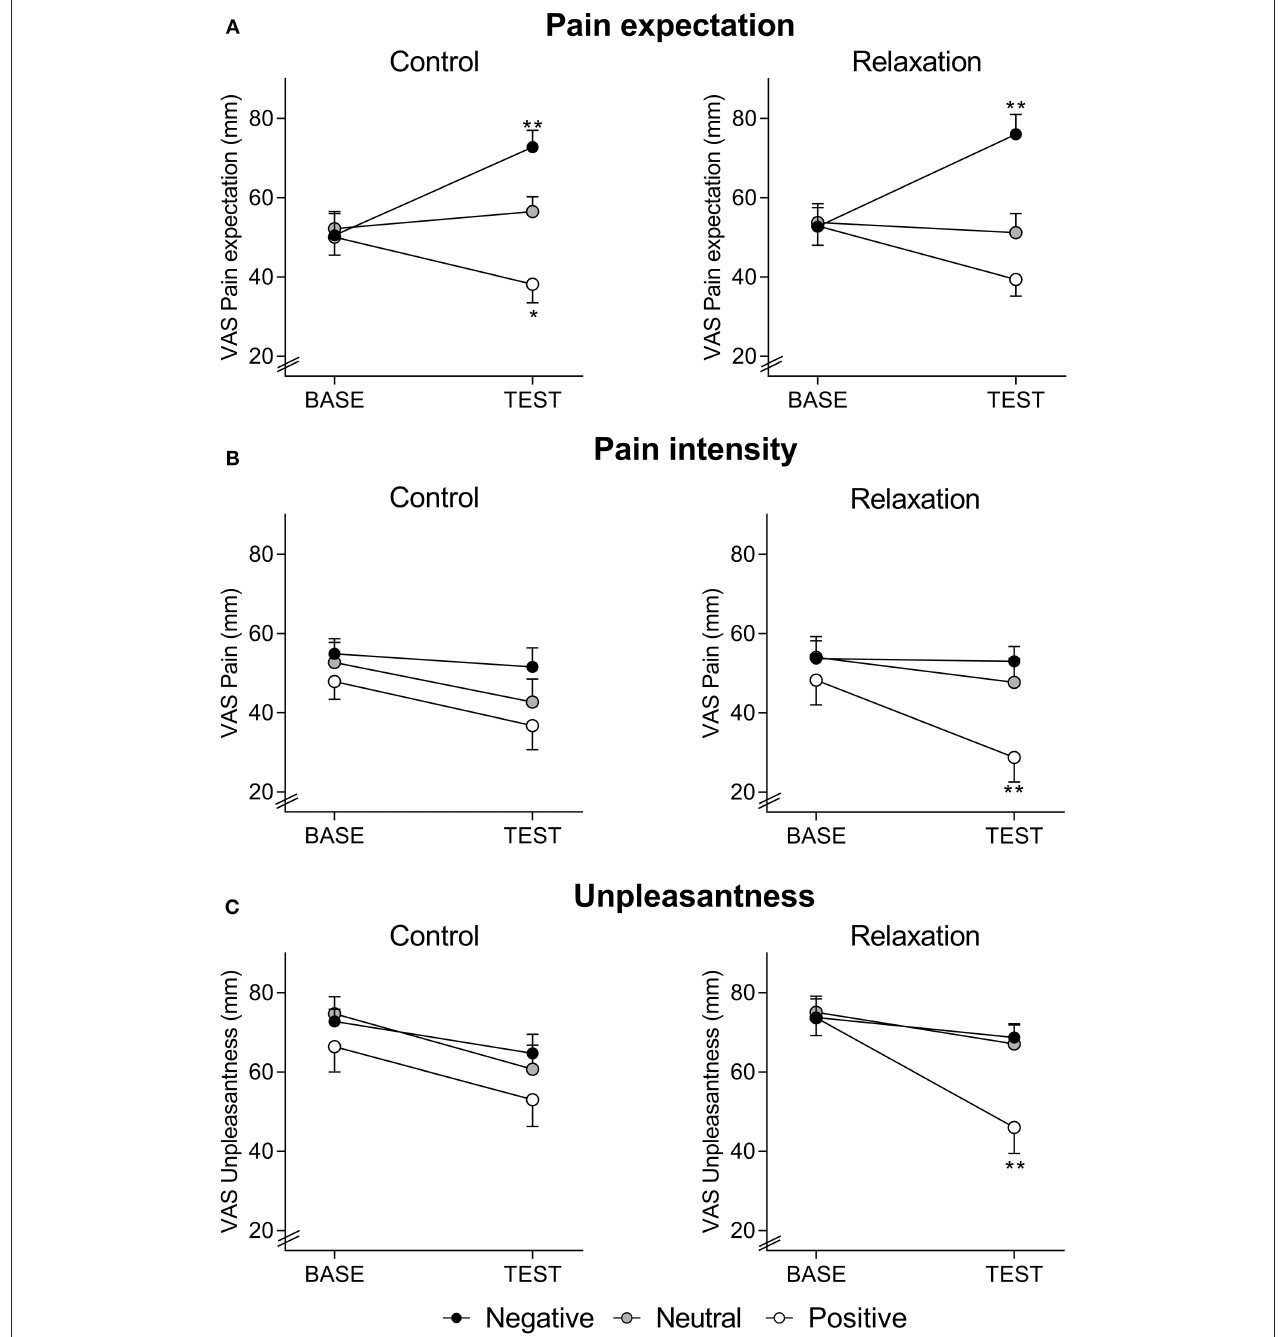
FIGURE 1 | Expected pain intensity (A) , perceived pain intensity (B), and perceived pain unpleasantness (C) , assessed with visual analog scale (VAS, 0–100mm) at BASELINE and TEST, in groups receiving positive, neutral, or negative treatment information after relaxation (right panels) or control (left panels). Note that pain expectation was assessed before, whereas perceived pain intensity and unpleasantness were assessed after the series of distensions during BASELINE and TEST, respectively. For ANCOVA results, please see text. * p < 0.05; ** p < 0.01 results of planned comparisons with Bonferroni-correction at TEST (for exact p -values, see text) comparing groups with positive information to groups with neutral information (to test for placebo effects) and groups with negative information to groups with neutral information (to test for nocebo effects) after either relaxation or control.